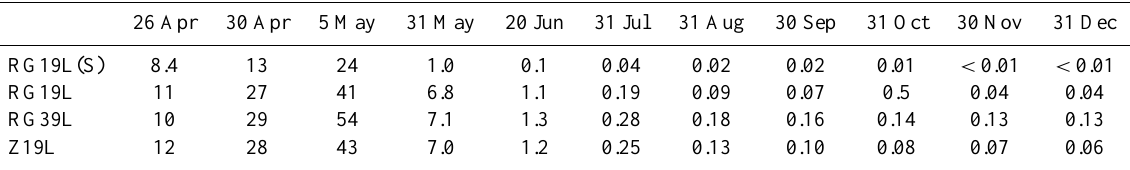
Table 2. Atmospheric burden of 137 Cs inPBq (with respect to the total emission of 85PBq) estimated from the different model-versions used for the Chernobyl simulation. RG19L(S) denotes the simulation in the regular grid (144 × 142) assuming surface emissions, RG19L the regular grid with the real emission height, RG39L the regular grid with a 39 layer vertical resolution and Z19L the zoom-version over 19 vertical